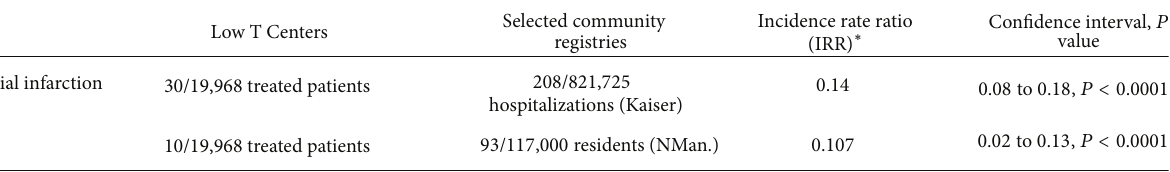
Figure 3: Summary of cardiac events in Low Testosterone (T) Centers and comparison registries (per 100,000